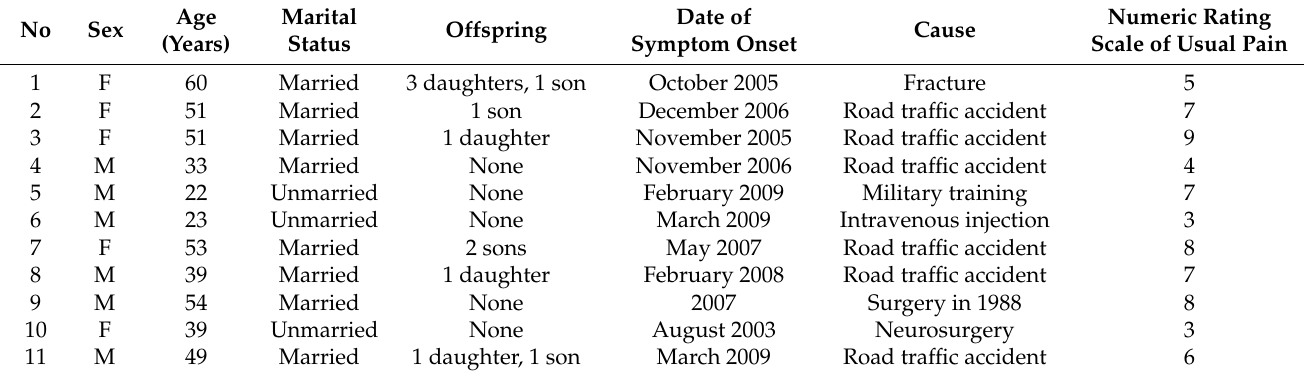
Table 1. Demographic data of the participants ( n =